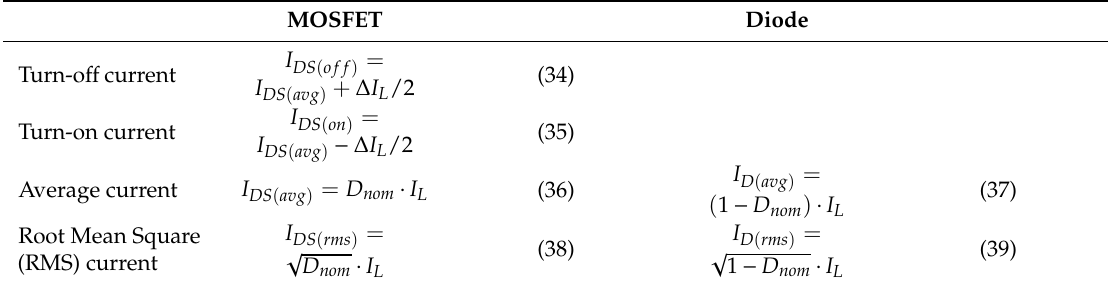
· V in , and the nominal L · f sw